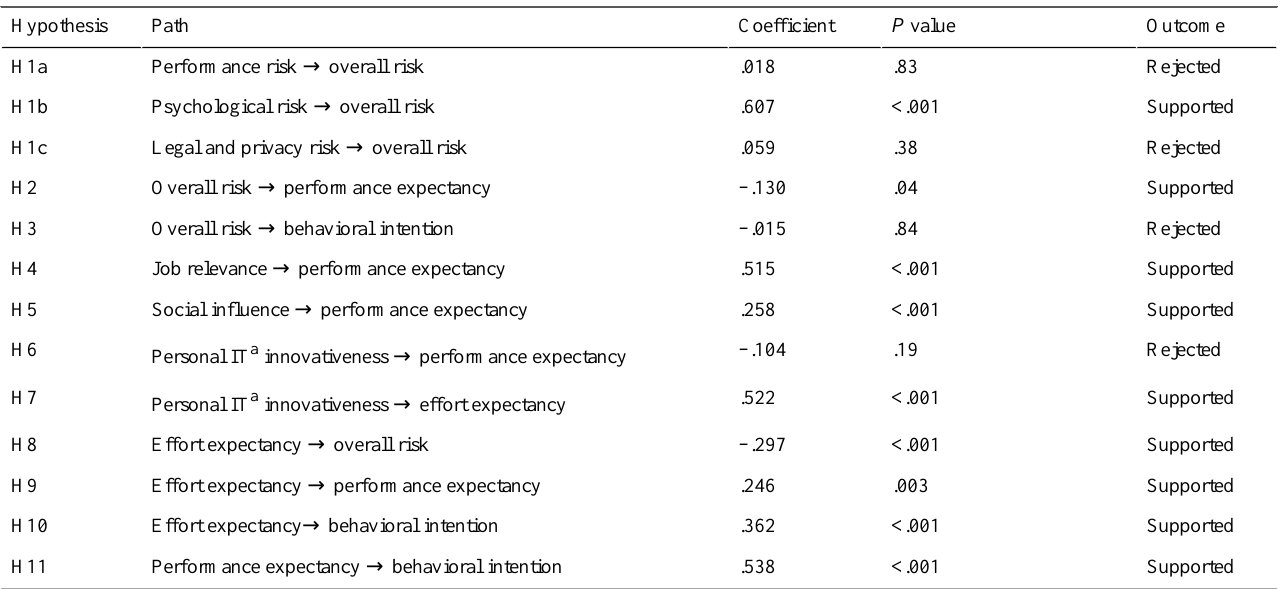
Table 3. Hypothesis test results for the EHR nonuser